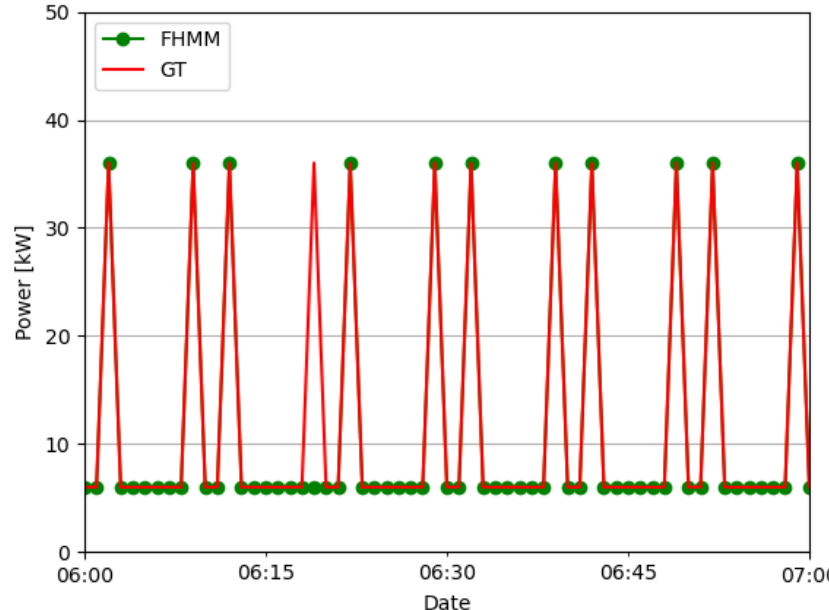
Figure 11. Air compressor power pattern and energy disaggregation results on 16 May.